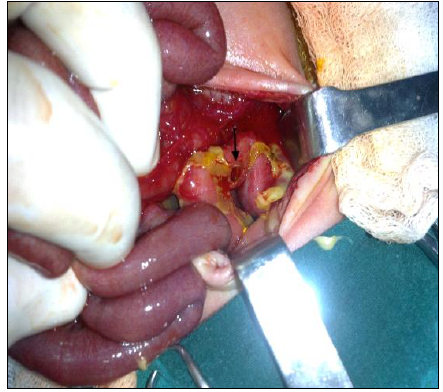
Figure 1: Focal perforation site on the 1/3 distal part of sigmoid